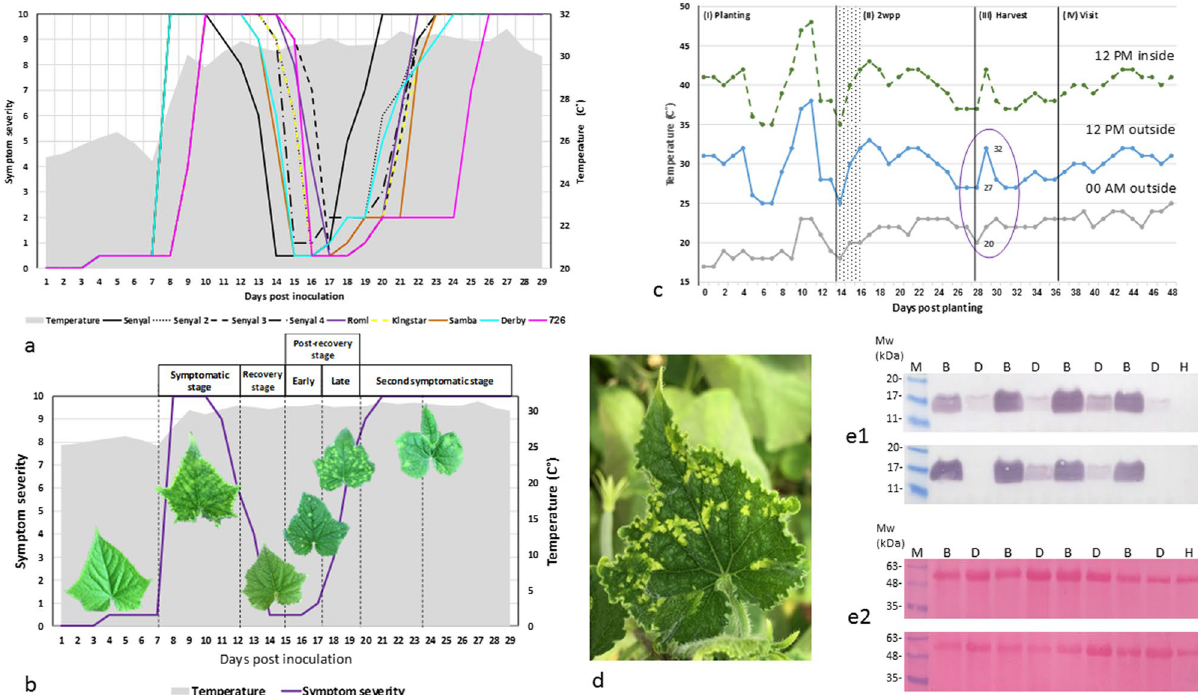
Figure 3. Establishing a CGMMV disease-phenotype progression scheme for ‘bright yellow island’ (BYI) development and its manifestation under natural environmental temperature conditions. ( a ) A graphical summary of CGMMV disease symptom manifestations during the gradual disease progression in the various tested CGMMV inoculated cucumber plants. Six different cultivars (7–60 plants in the various experiments) were subjected to an abrupt temperature raise from 25 ± 2 °C to 32 ± 2 °C at the pre-symptomatic stage, 7 days post inoculation. Plants were inspected daily. Temperature logging was automatic, at hourly intervals, marked by a grey area. The various cv . line symbols are: Senyal (4 replications), black symbols of a solid line, a dashed line, a long dashed-dot line and a round dot line ; Romi; a purple solid line; Kingstar; a yellow square dotted line; Samba, an orange solid line; Derby, a light blue solid line and 726, a pink solid line. ( b ) An integrated CGMMV disease progression scheme illustrating periodical symptom manifestations following the abrupt temperature raise, marked by a purple line. A grey line marks the monitored temperatures. Symptom severity ratings: 0–1: no visible symptoms; 2: bright yellow islands; 3–7: slight to medium severity showing a combined phenotype of yellow patched mottling; 7 and higher: severe symptoms of yellow patched mottling and mosaic on slightly deformed leaves associated with systemic CGMMV infection (ELISA OD value range of 0.26–1.22, negative reference OD: 0.01). ( c ) The BYI manifestation time-table postulated BYI detections in cucumber plants cultivated in a commercial net-house following a heat wave (marked by a purple ellipse). Recorded high and low environmental temperatures were marked by blue and grey lines, respectively. Recorded temperatures inside the greenhouse were marked by a dotted (green) line. I, a presumed primary infection at planting; II–III, a presumed secondary spread upon trellising and harvest; wpp, weeks post planting. ( d ) A cucumber leaf from the commercial greenhouse showing BYIs. ( e1 ) Western blot analyses of 8 selected plants, collected from 4 different commercial net-houses, showing various stages of BYI development. ( e2 ) detection of loaded proteins by Ponceau S staining. B, bright yellow islands; D, corresponding dark green surrounding leaf tissues; H, negative control; M, molecular weight